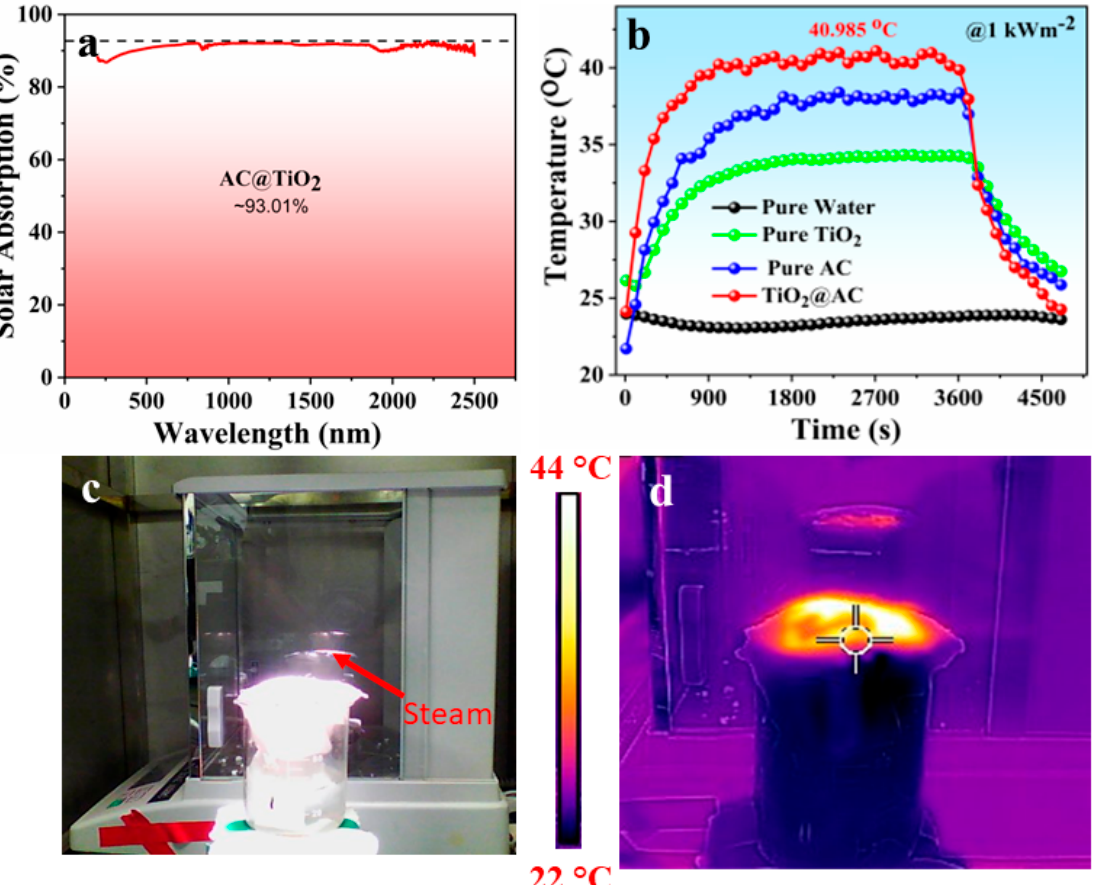
Figure 4. ( a ) UV-Vis’s spectra of TiO 2 /AC nanocomposite showing supreme solar absorption. ( b ) The surface temperature changes of the comparative four systems, i.e., pure water, pure TiO 2 , pure AC, and TiO 2 /AC under one sun. ( c , d ) Real-time demonstration of vapor generation and respective IR image of TiO 2 /AC solar evaporator under one sun irradiation.